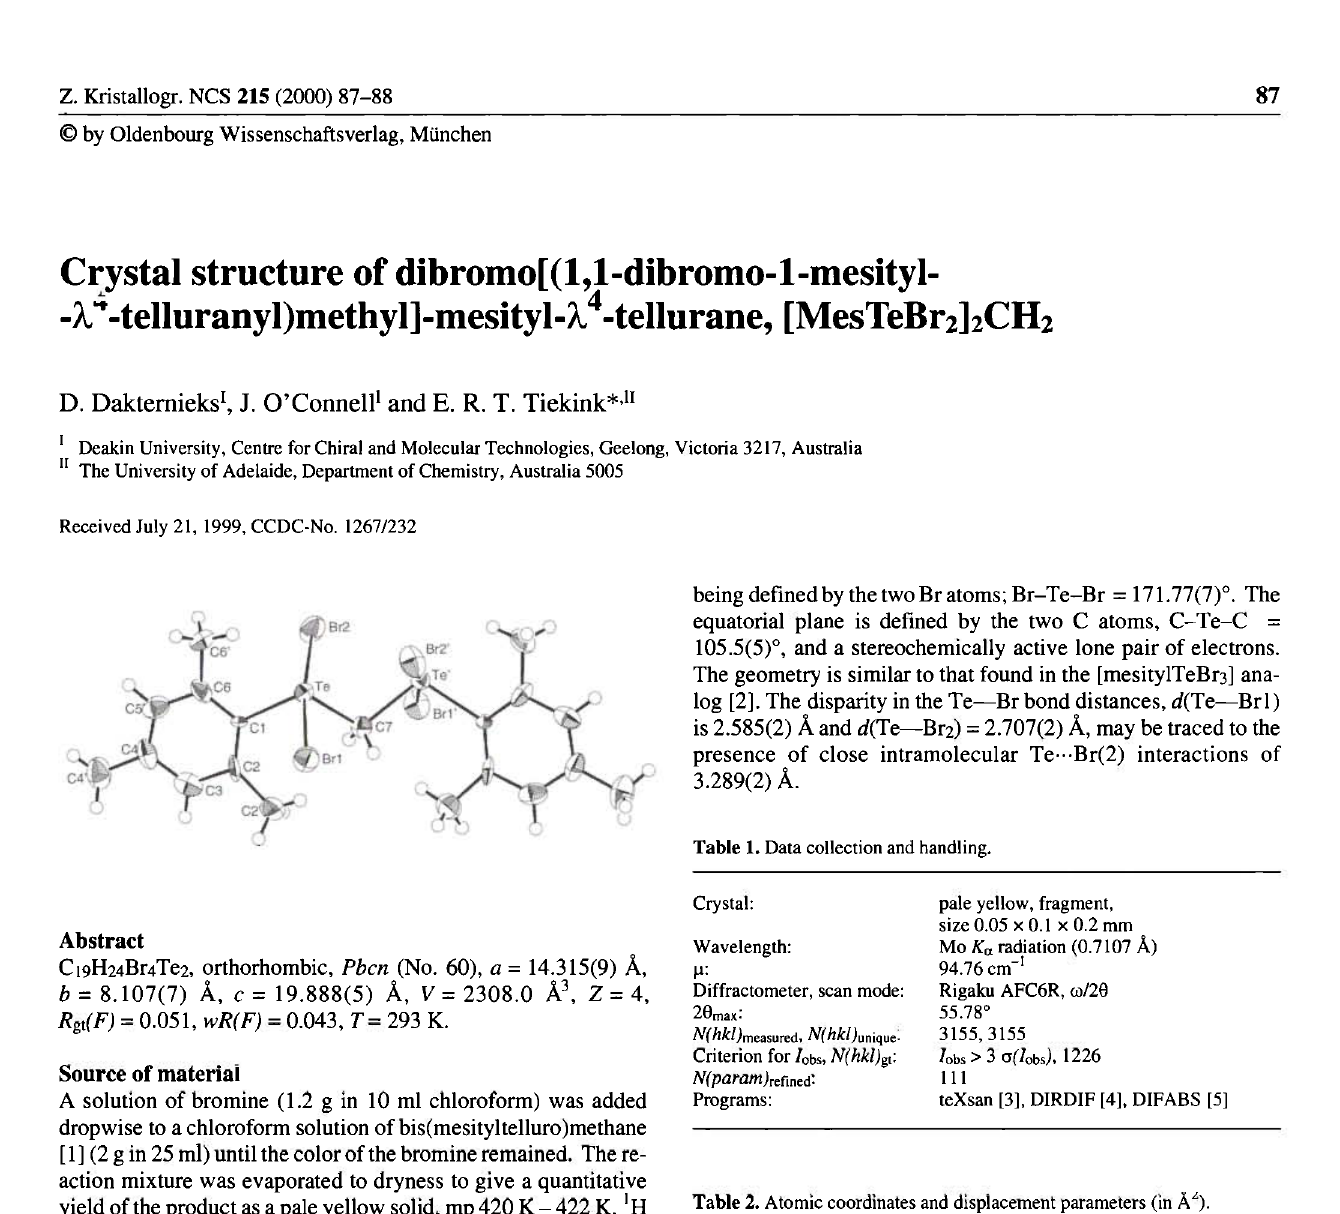
Table 2. Atomic coordinates and displacement parameters (in Ä